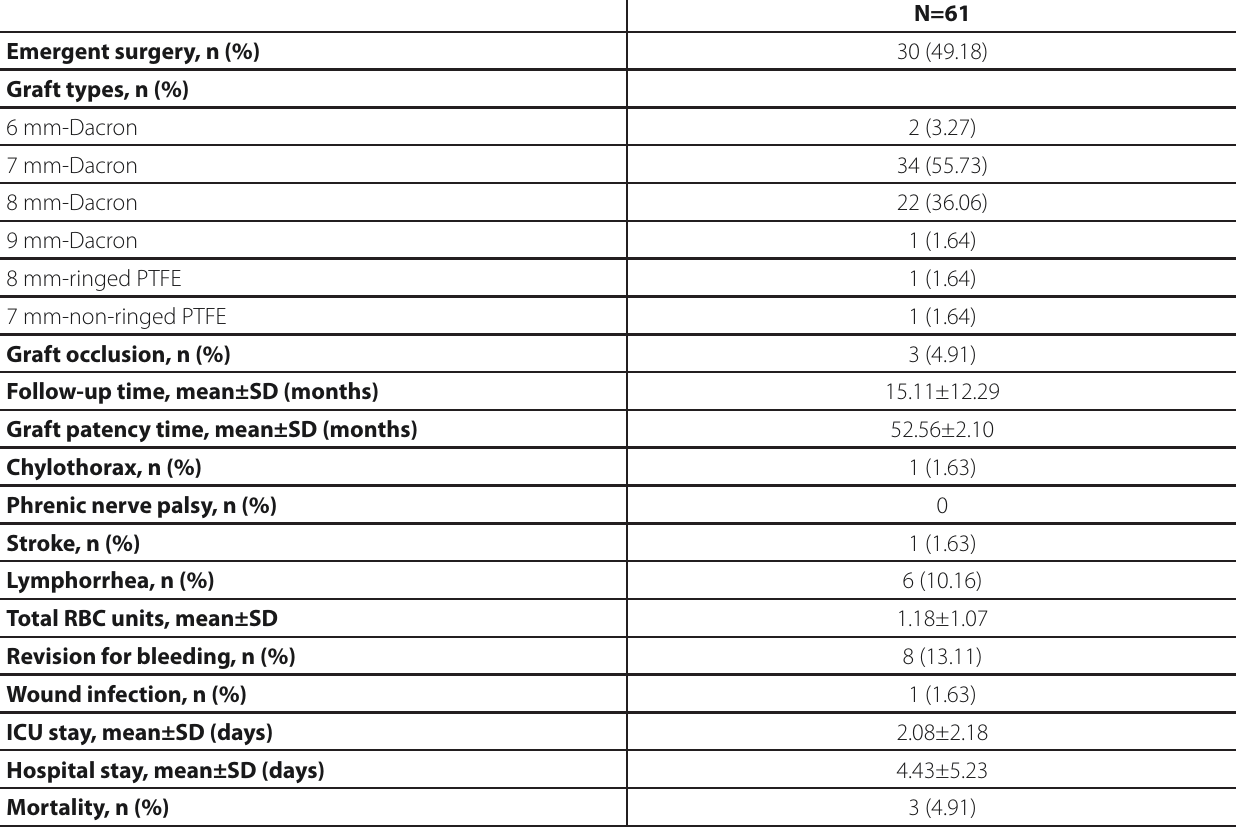
Table 2. Postoperative